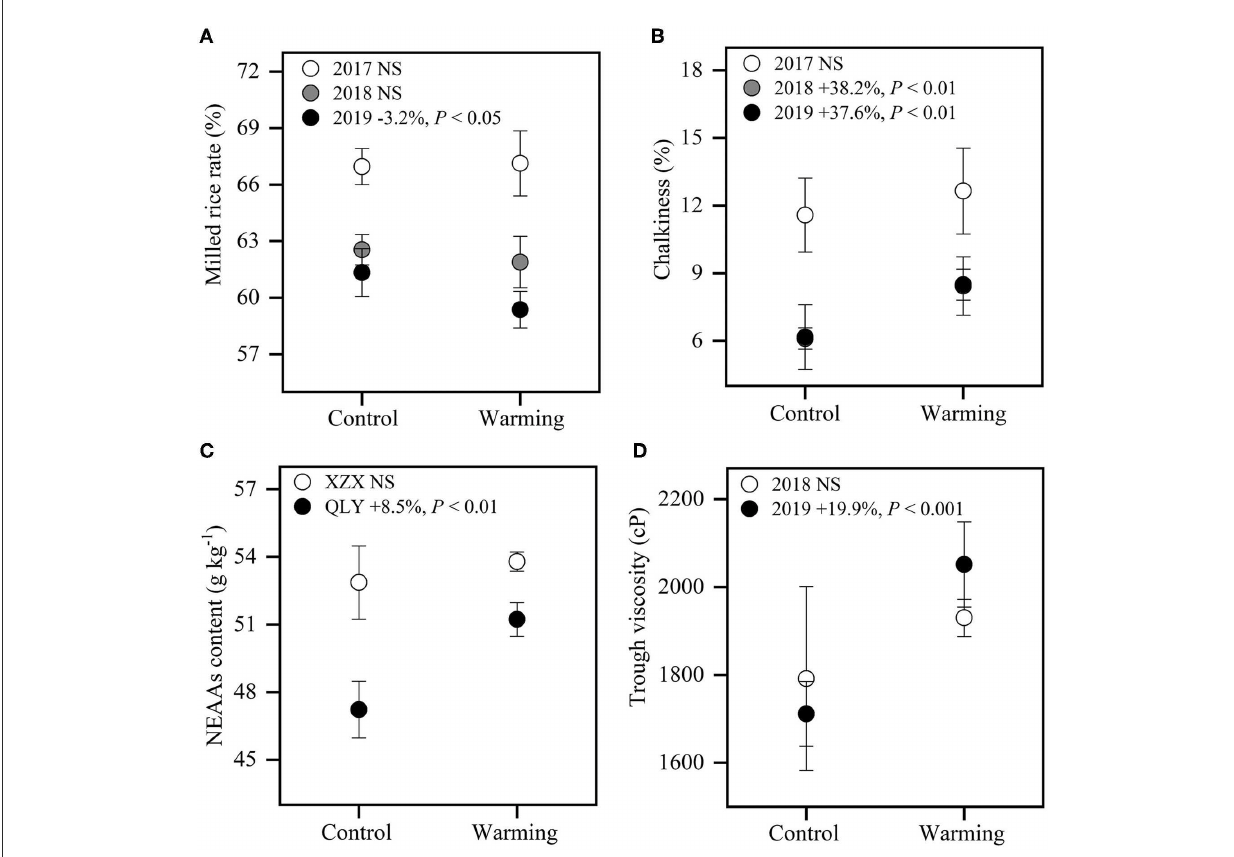
FIGURE1 Milled rice rate (A) , chalkiness (B) , non-essential amino acids (NEAAs) content (C) , and trough viscosity (D) as affected by warming, year, or cultivar. These variables showed significant warming × year or warming × cultivar interactions, so data are presented for each year or cultivar. NS means non-significant.